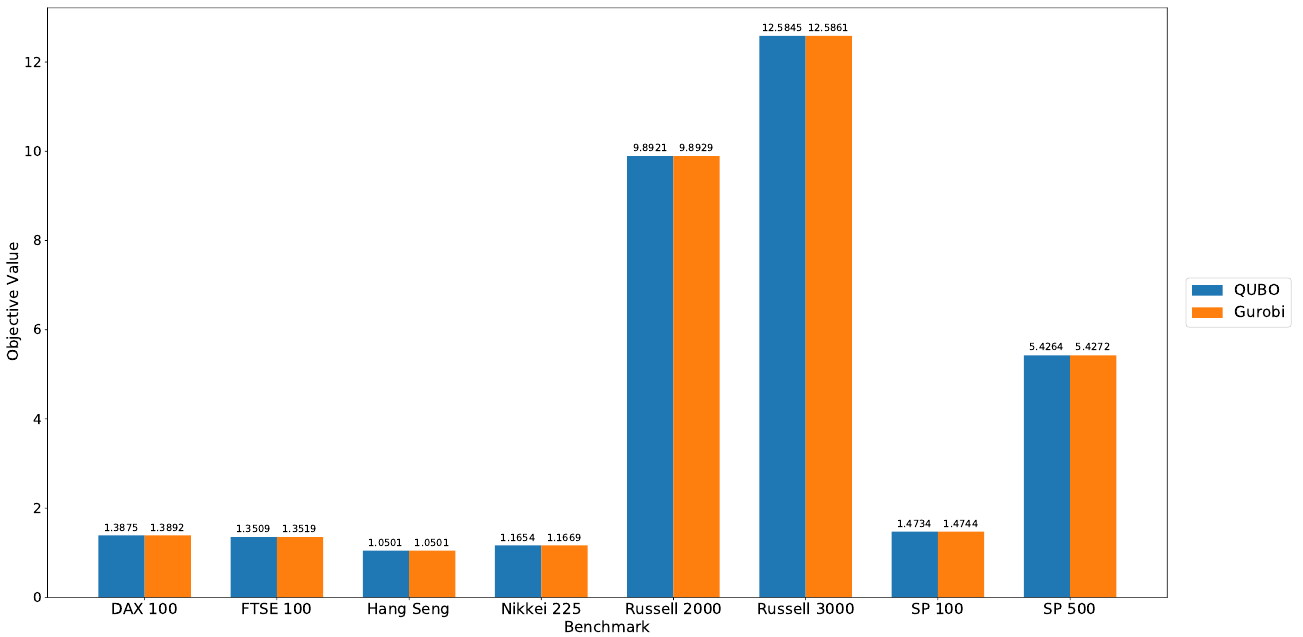
Figure 2. Objective Function Values of the Digital Annealer (DA) and Gurobi (lower is